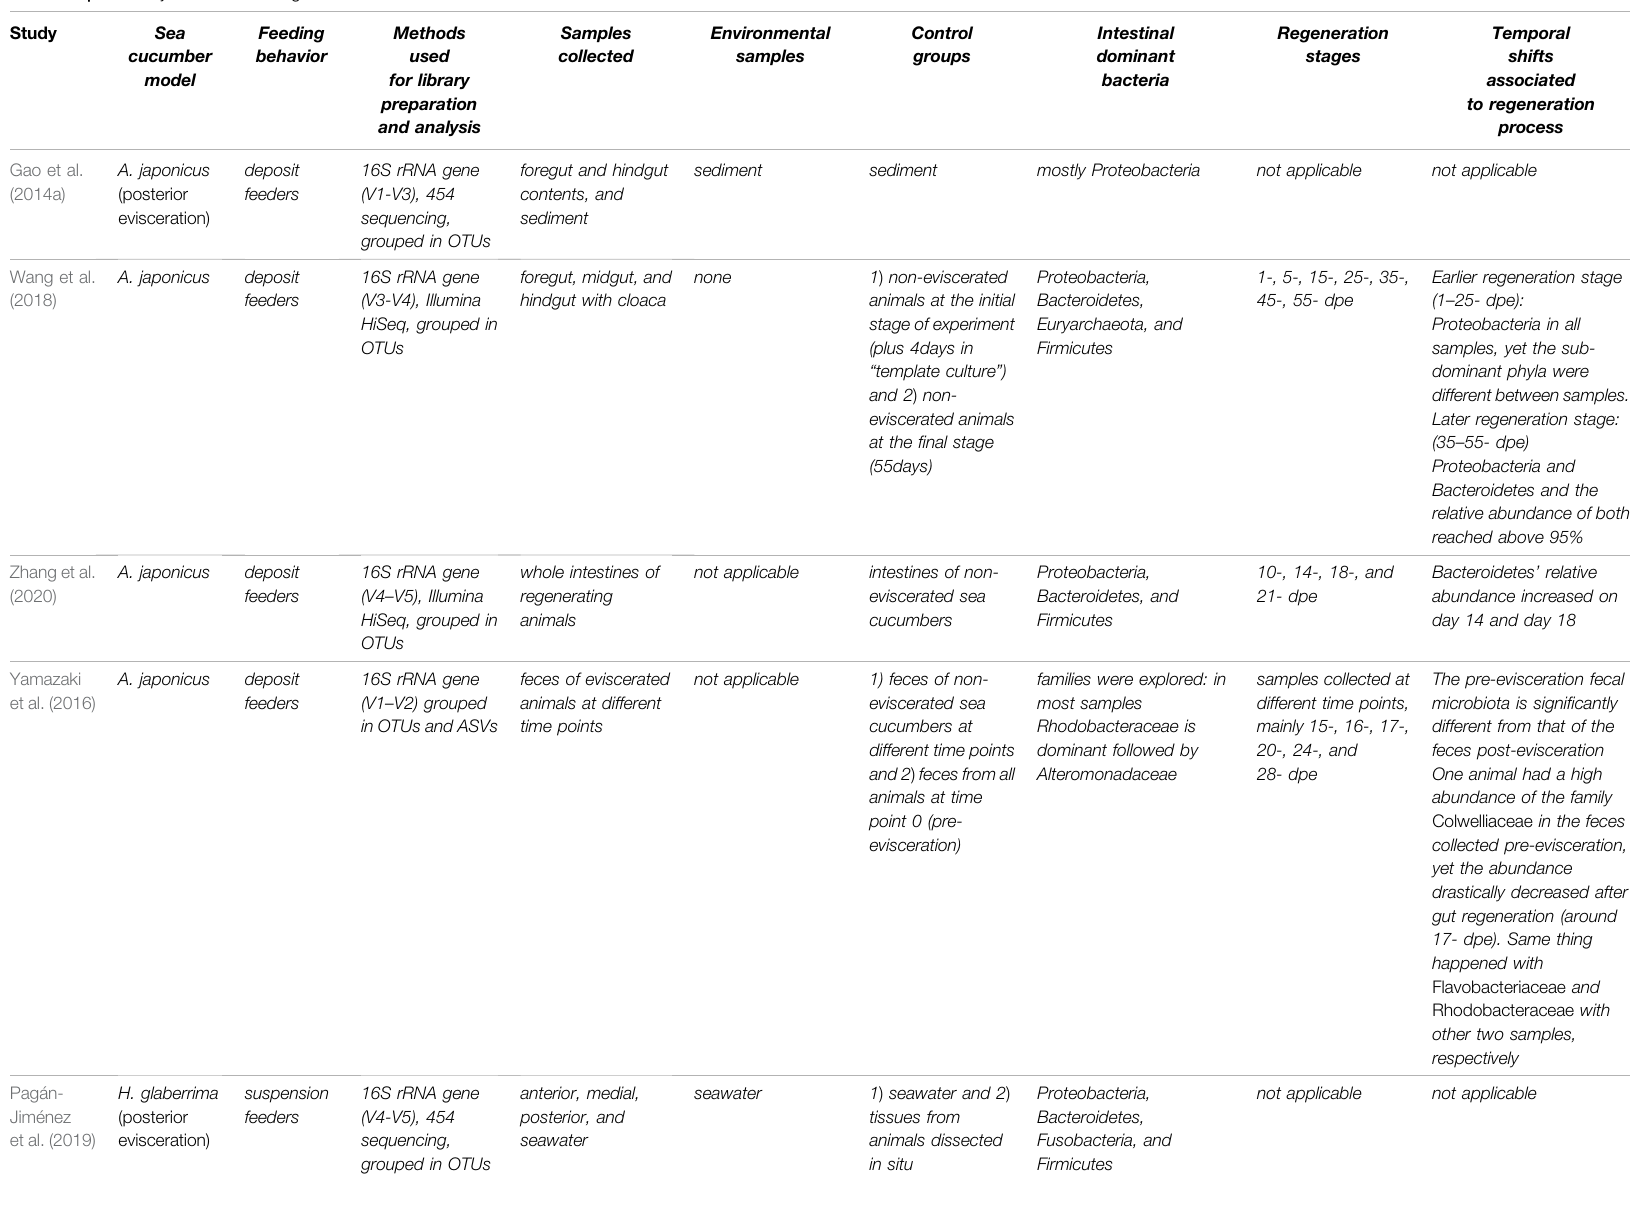
TABLE 2 | Summary of current fi ndings on sea cucumbers intestinal microbial